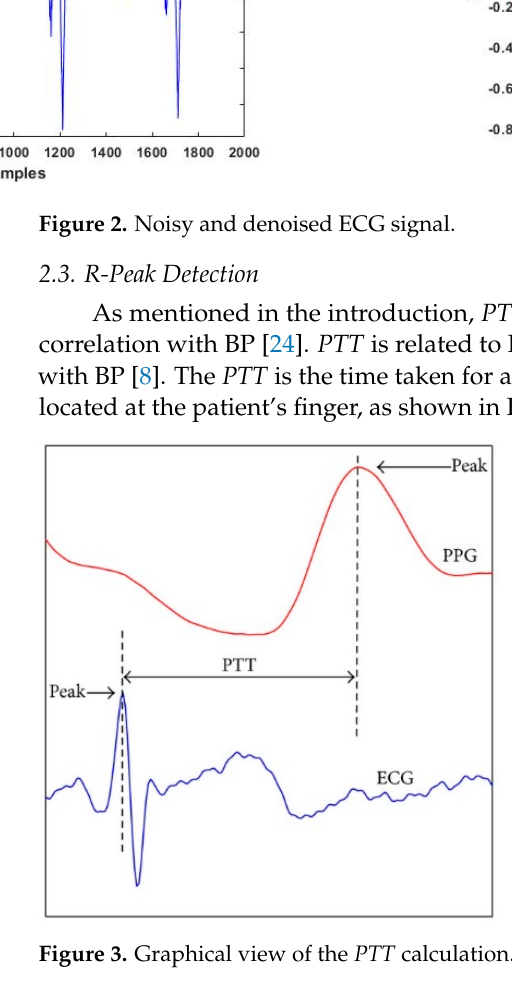
Figure 3. Graphical view of the PTT calculation.